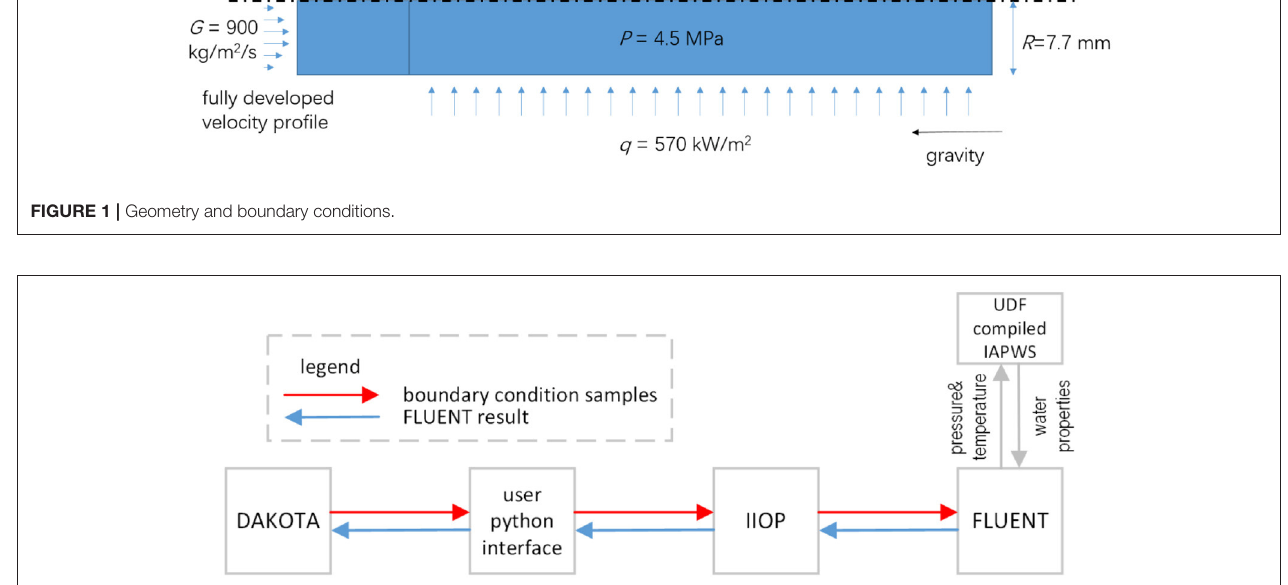
FIGURE 2 | Data flow chart for the uncertainty